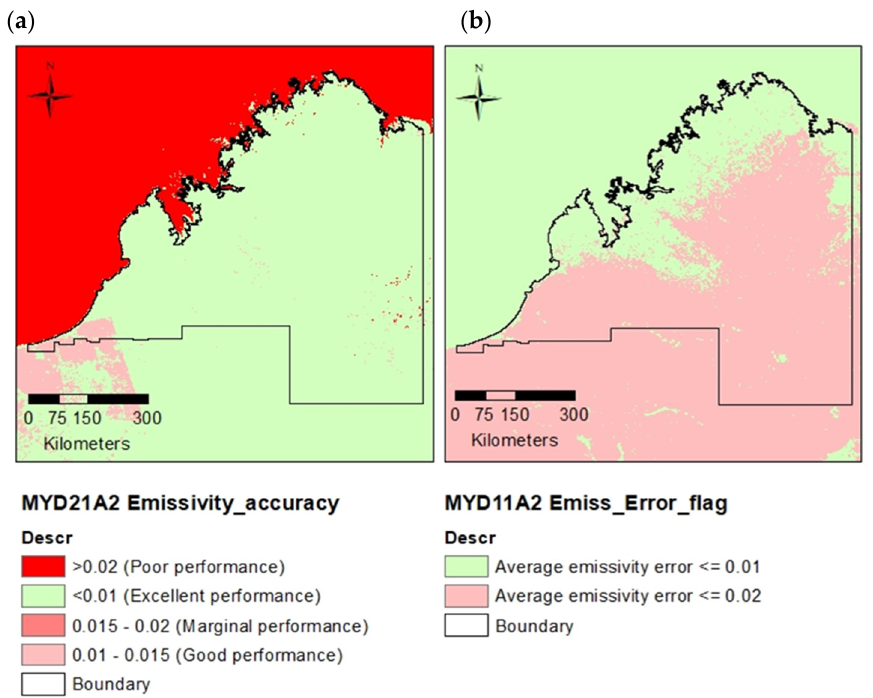
Figure 14. Image 2019009 , Kimberley emissivity error comparison: ( a ) MYD21A2 and ( b ) MYD11A2.